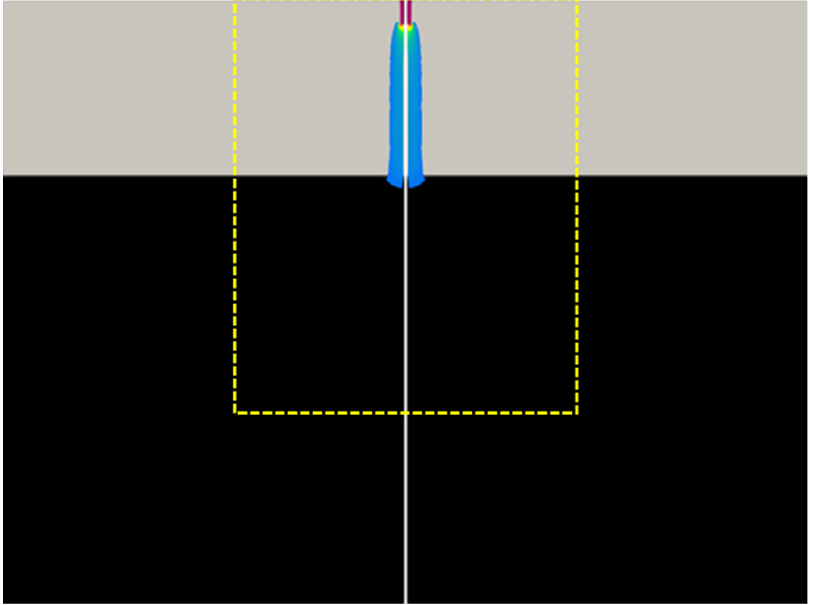
Figure 6. Simulation domain. The yellow frame shows the zoomed domain for a better visual depiction. Once the arc jet reached the liquid surface, an impingement wave formed pushing the liquid metal downwards and displacing it away from the jet path (Figure 7). Figure 7 illustrates the arc impingement for the reference model during different time snaps. The left half shows the electric current lines ( J is the current density) and the right half shows the velocity magnitude of the gas ( U is the velocity magnitude). The liquid metal is shown in black. This applies for all the following figures that display the arc impingement. The wave initially propagated vertically and then created a wide cavity. The arc jet pushed the liquid metal droplets upwards, as shown in the 0.286 s image in Figure 7. The cavity expanded and shrank continuously and a wave travelled along the surface. The splashing of droplets appeared to be continuous and the droplets were transported far away from the arc impingement location. A few of the droplets recirculated inside the arc region. The motion of the arc was instantaneously compared with the aerodynamics and motions of the liquid metal. The arc tended to choose the shortest distance in the gas to reach the liquid metal (Figure 7, 0.8 s). When the shortest distance between the electrode and the liquid metal was different from the original path position (near the axis) the arc deviated, as shown in Figure 7, 0.8